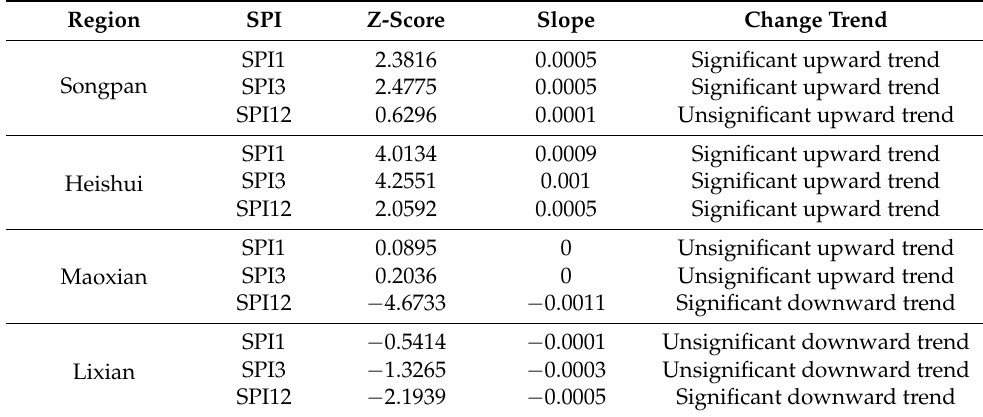
Table 2. Test results of change trend of drought index at different time scales.